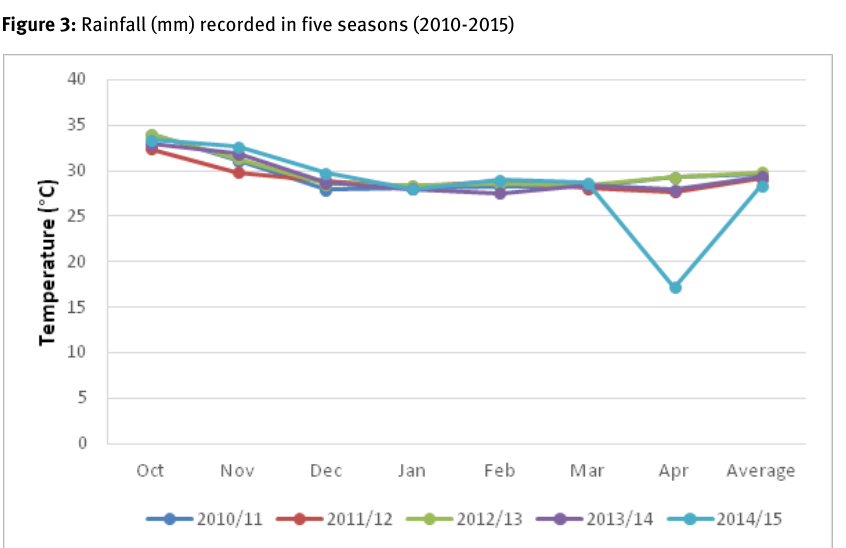
Figure 3: Rainfall (mm) recorded in five seasons (2010-2015)